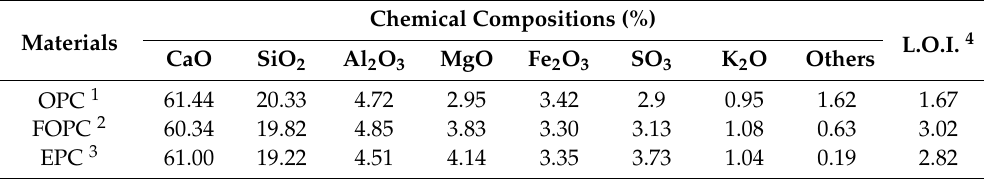
Table 1. Chemical composition of binders used in this study, as observed via X-ray fluorescence (XRF) analysis.